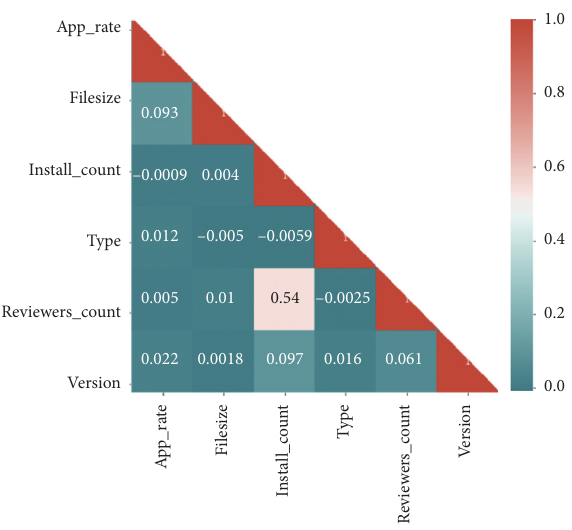
Figure 8: Correlation matrix between app Table 2: Suggested app classification identified after applying the LDA algorithm.